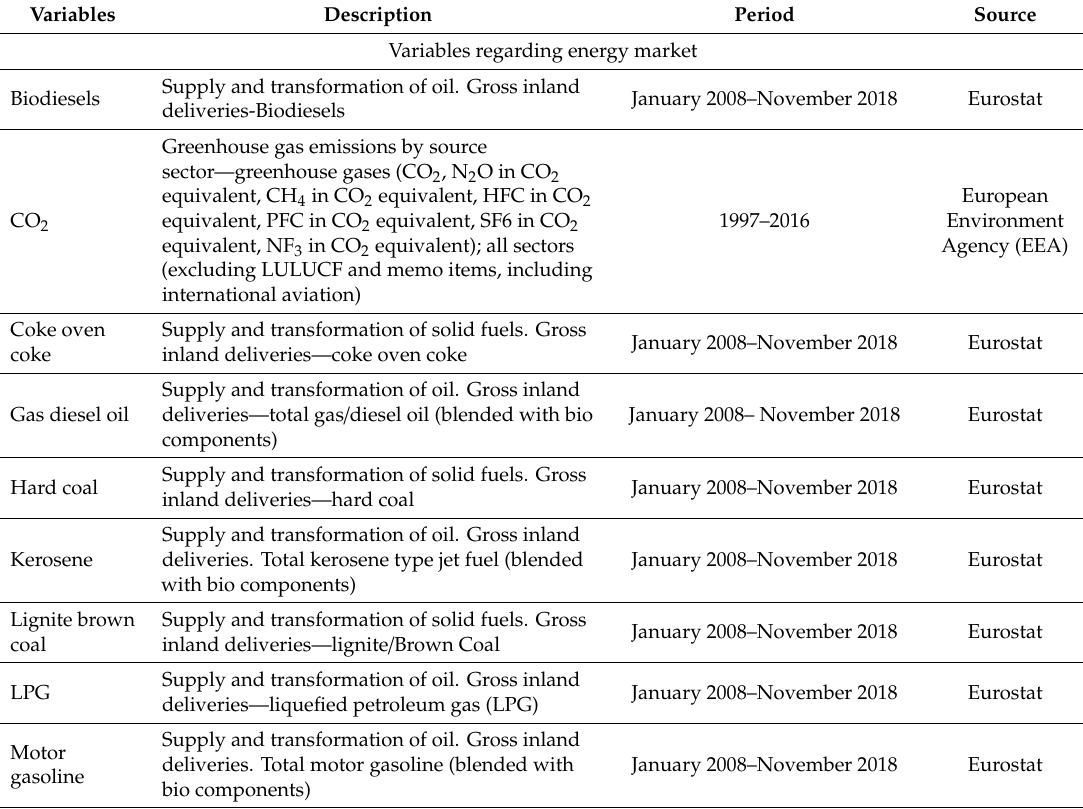
Table 2. Variables’